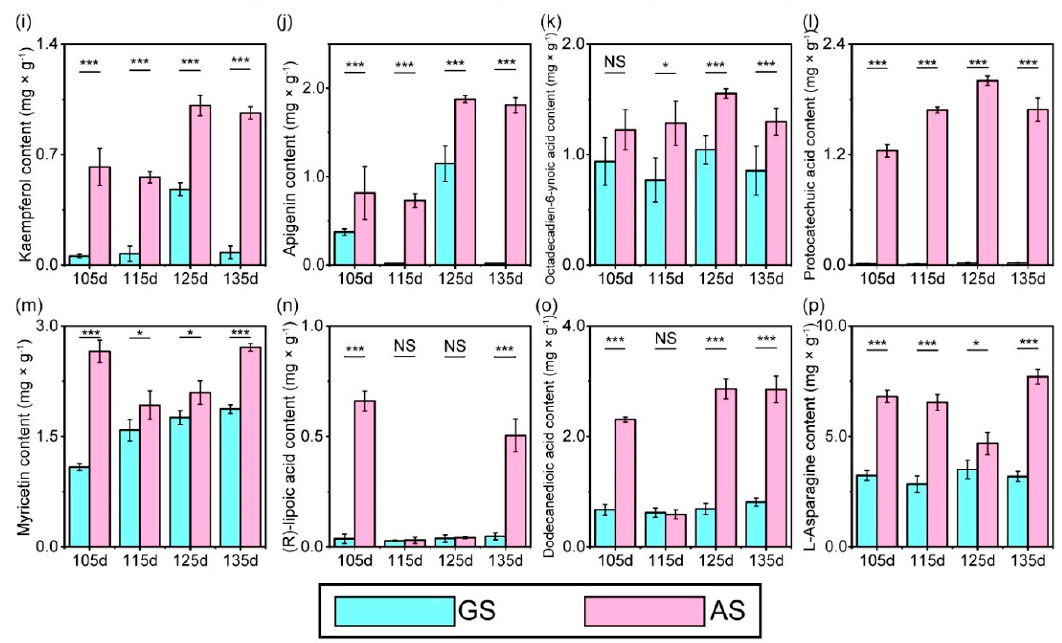
Figure 4. Concentrations of the 16 selected DEMs in AS and GS at different stages. Metabolites including quinine ( a ), dihydrozeatin ( b ), 5-hydroxy-L-tryptophan ( c ), robinin ( d ), H-homoarg-OH ( e ), methyl nicotinate ( f ), 3-indoleacetonitrile ( g ), quercetin ( h ), kaempferol ( i ), apigenin ( j ), octadecadien-6-ynoic acid ( k ), protocatechuic acid ( l ), myricetin ( m ), (R)-lipoic acid ( n ), dodecanedioic acid ( o ), and L-asparagine ( p ) were selected randomly. Darker bars indicated the concentrations of the corresponding metabolites in GS group, while the lighter bars indicated that of in AS group. Asterisks above the bars represented the significant level of the difference. Significance at p < 0.01 level was marked with “***”; at p < 0.05 level it was marked with “*”; while at p > 0.05 level it was marked with “ NS ” which meant no significant difference between those samples.